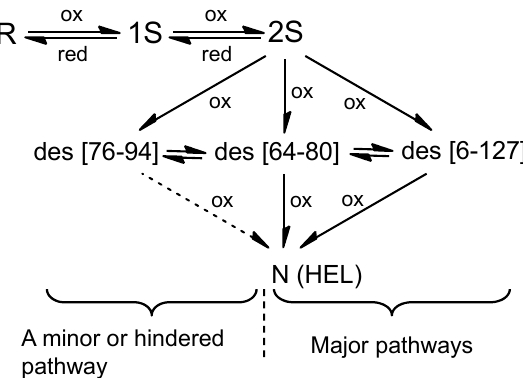
Figure 1. Oxidative folding pathways of HEL at 20 °C and pH 8.5 in the presence of 2